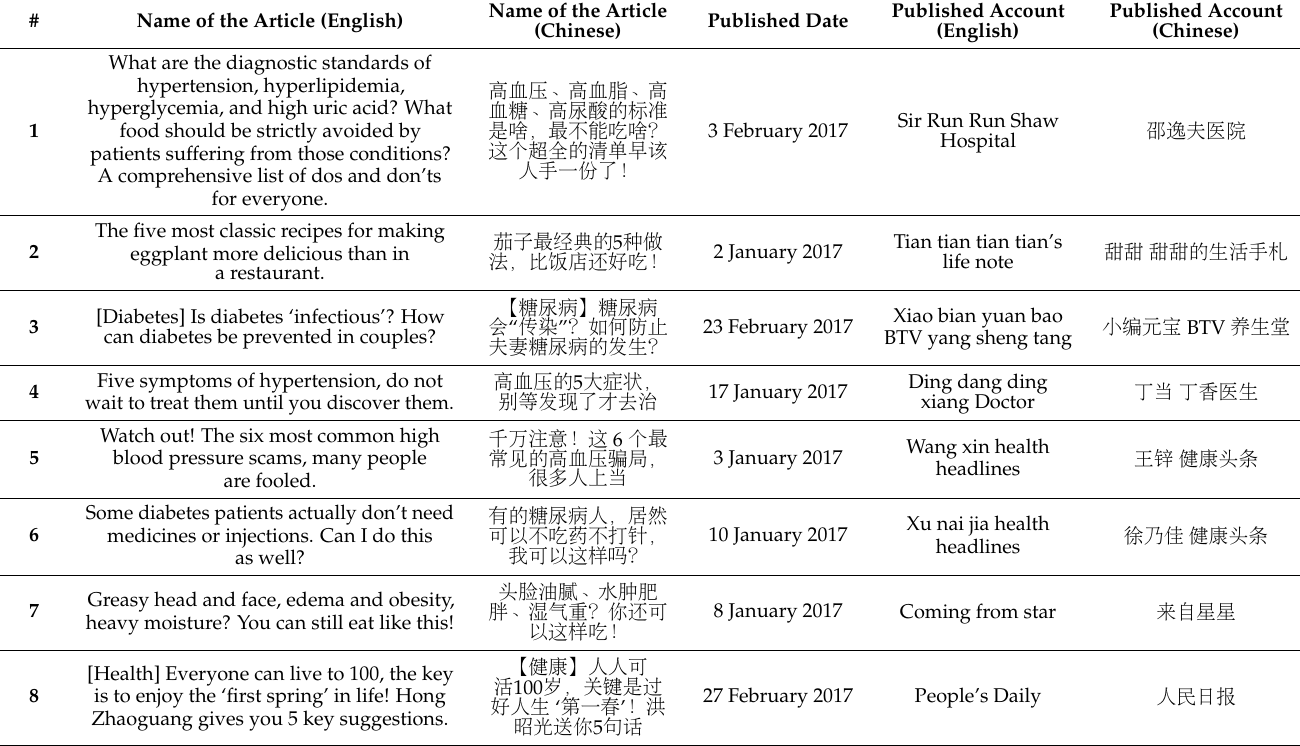
Table A1. Overview of the WeChat Articles Shown in the